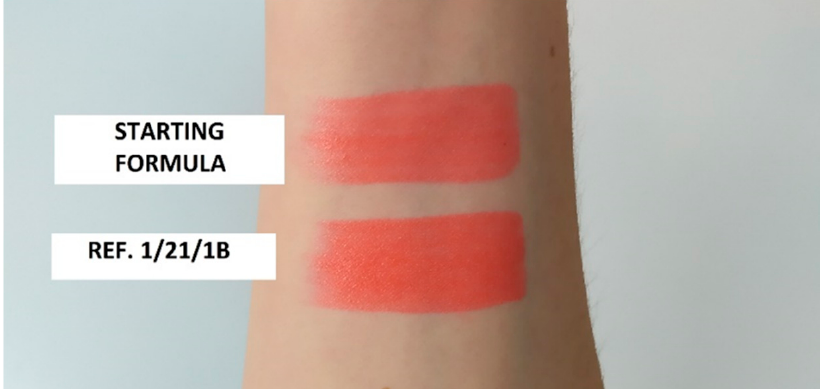
Figure 5. Trace of Starting Formula vs. Ref. 1/21/1B.